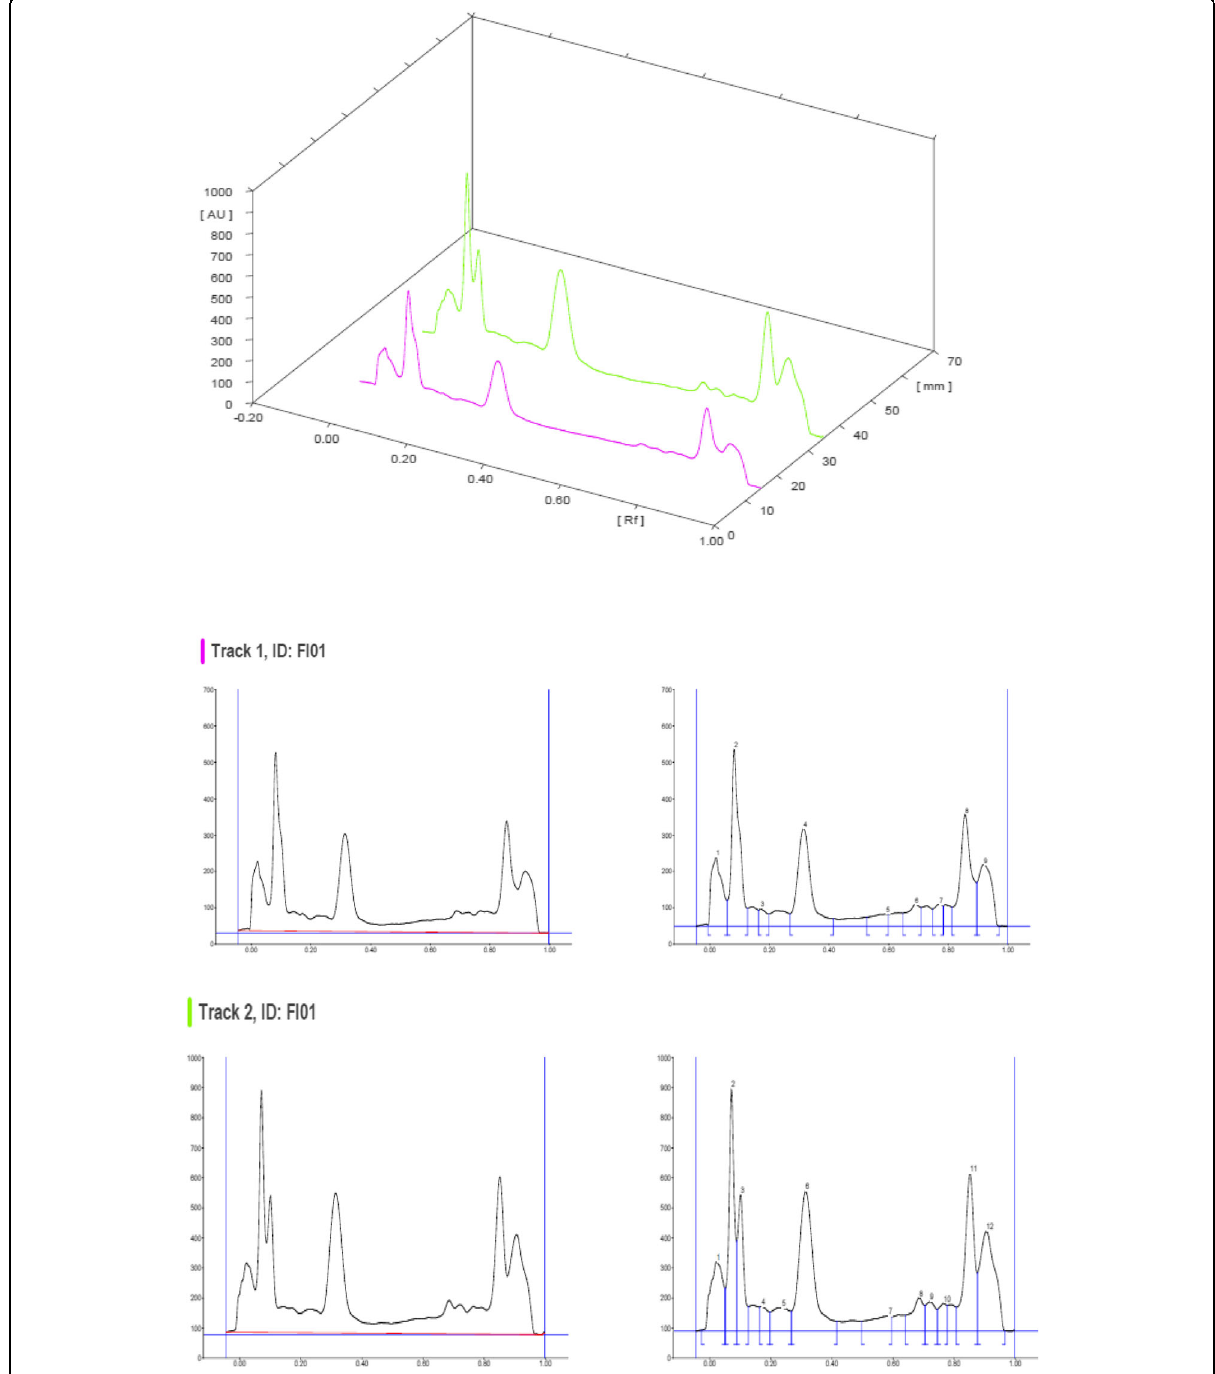
Fig. 3 HPTLC chromatograms scanned at 366